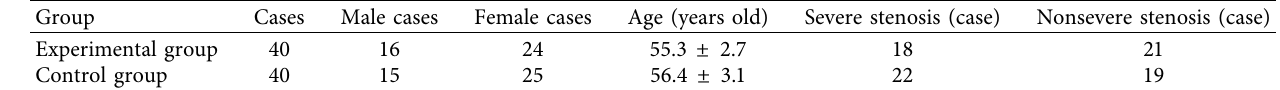
Table 1: General patient